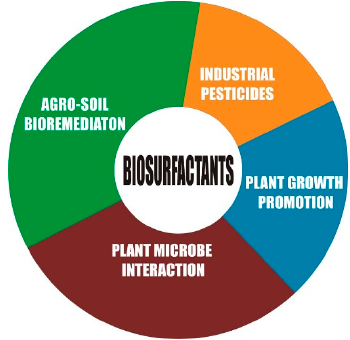
Figure 5. Application of biosurfactants in the agriculture sector.